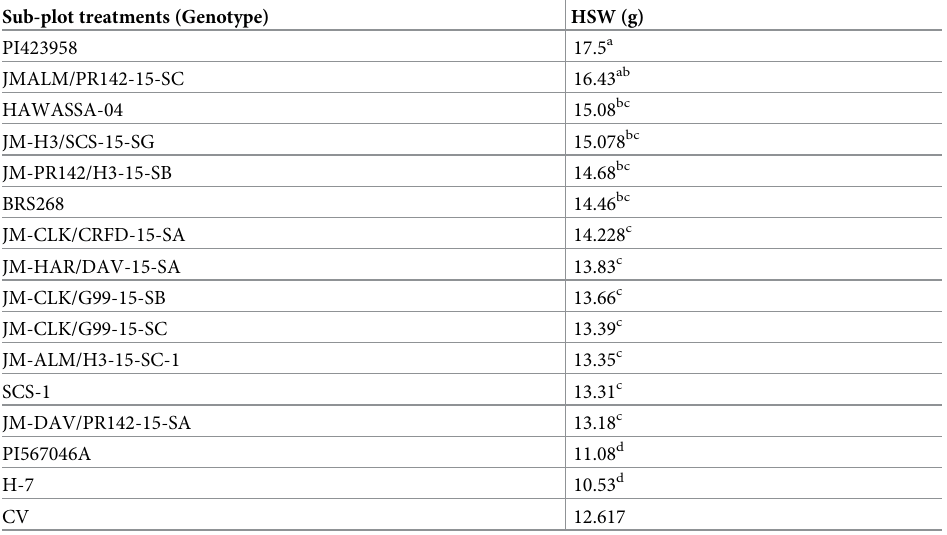
Means with the same letters are not significantly different at 5% level of significance. HSW = hundred seed